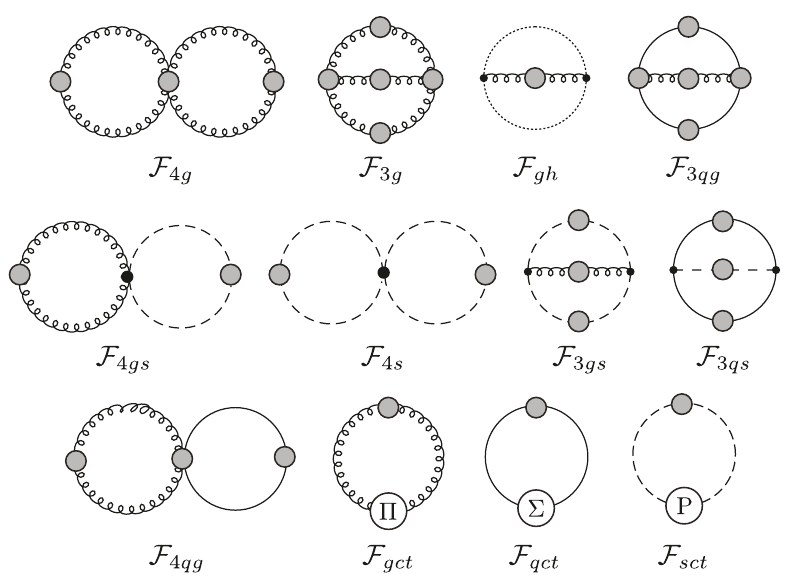
Figure 3 . Two loop Feynman diagrams for N = 4 SYM theory in HTLpt. Dashed lines indicate a scalar (cid:12)eld and dotted lines indicate a ghost (cid:12)eld. Shaded circles indicate HTL-dressed propagators and